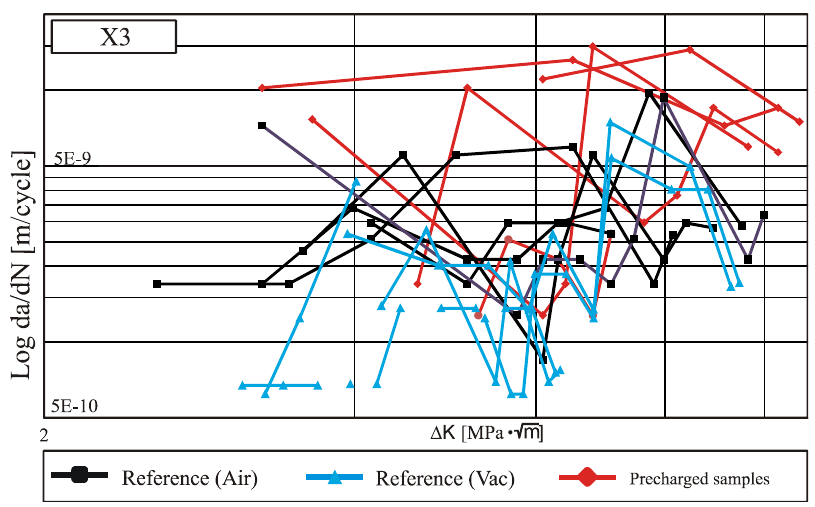
Figure 13. Crack growth rate of precharged specimens (5 wppm) and reference specimens (Air, vacuum) of the X3, R = −1, Δσ/2 = 640 MPa (Vac), Δσ/2 = 665 MPa (Air, precharged).